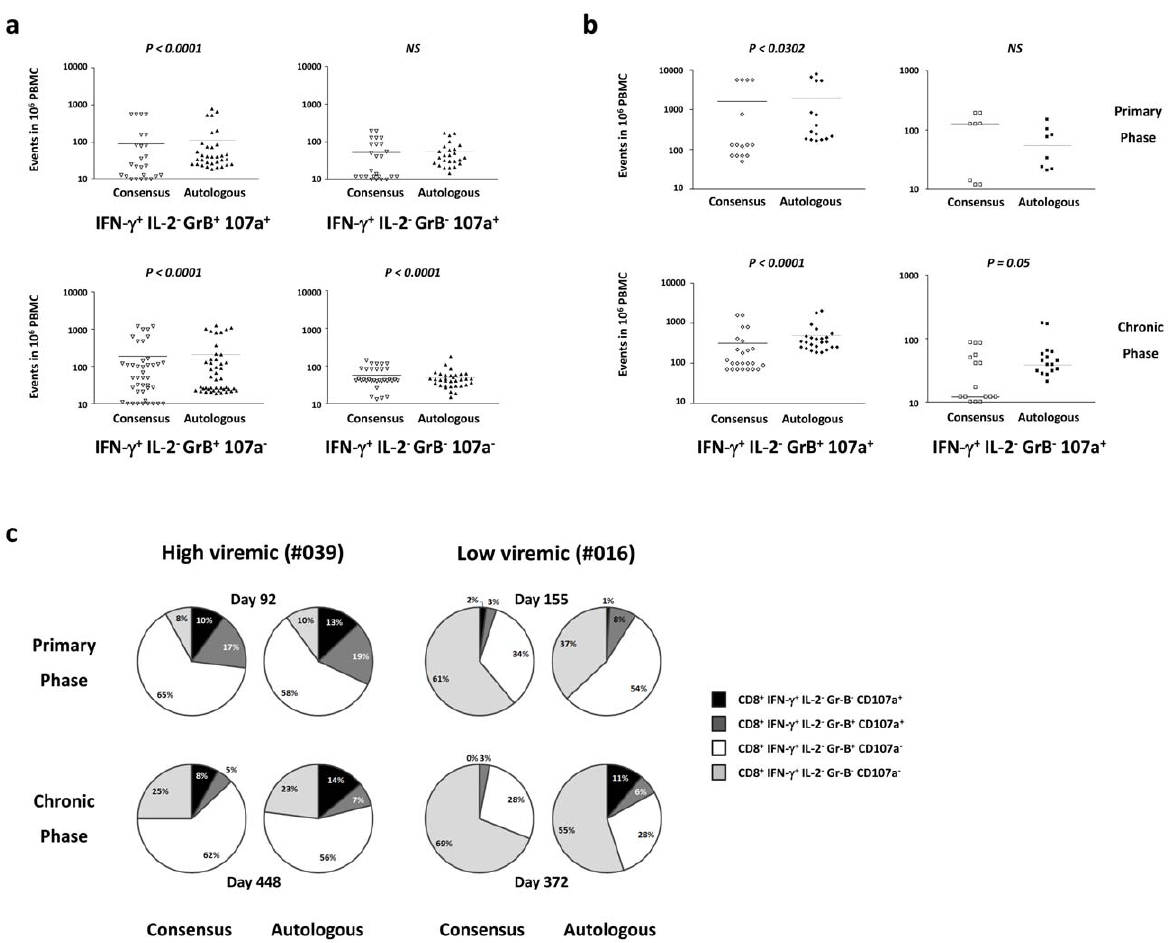
Figure 3. Greater frequency of polyfunctional IFN- c producing CD8 + T-cells with autologous HIV-1 Nef peptides. (a) The frequency of CD8 + IFN- c + Gr-B + CD107a + detected by autologous HIV-1 Nef peptide and clade-B consensus Nef peptide stimulation. Functional subpopulations were defined by sequential gating of Gr-B and CD107a on CD3 + CD8 + IFN- c + cells. Each point in the graphs represents the response to one overlapping peptide. The responses of both subjects in both time points are shown together in each graph. (b) CD8 + IFN- c + Gr-B + CD107a + and CD8 + IFN- c + Gr-B 2 CD107a + T-cells detected by using autologous HIV-1 Nef and clade-B consensus Nef peptides in the chronic phase of infection. Each point in the graphs represents the response to one overlapping peptide. The responses of both subjects are represented in each graph. (c) Percentage of mono-, oligo- and polyfunctional CD8 + T-cells targeting pairs of consensus and autologous HIV-Nef peptides in an ICS assay. The graph represents an example of the difference in the function of stimulated CD8 + T-cells between the two subjects.